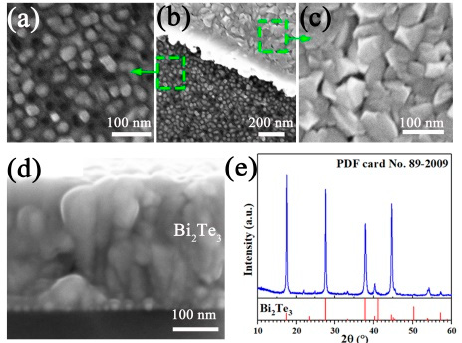
Figure 2. SEM image of ( a ) Ag/Al 2 O 3 , ( b ) Ag/Al 2 O 3 /Bi 2 Te 3 , and ( c ) Bi 2 Te 3 . ( d ) Cross section of Ag/Al 2 O 3 /Bi 2 Te 3 . ( e ) XRD pattern of Bi 2 Te 3 .